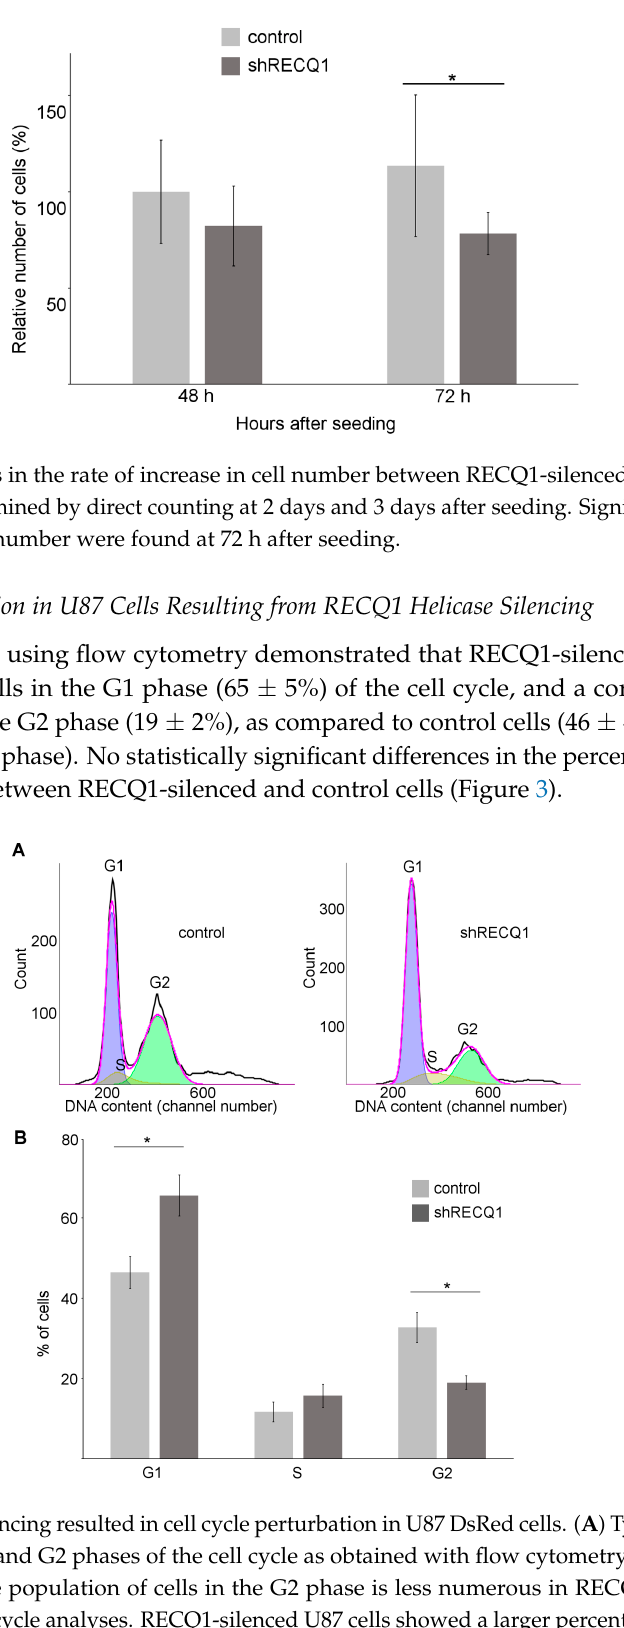
Figure 3. RECQ1 silencing resulted in cell cycle perturbation in U87 DsRed cells. ( A ) Typical histograms of cells in the G1, S, and G2 phases of the cell cycle as obtained with flow cytometry after propidium iodide staining. The population of cells in the G2 phase is less numerous in RECQ1-silenced cells; ( B ) Summary of cell cycle analyses. RECQ1-silenced U87 cells showed a larger percentage of cells in the G1 phase and a smaller percentage of cells in the G2 phase, whereas there was no significant difference in the percentage of cells in the S phase. Means ± SE are shown. Significance: * = p ≤